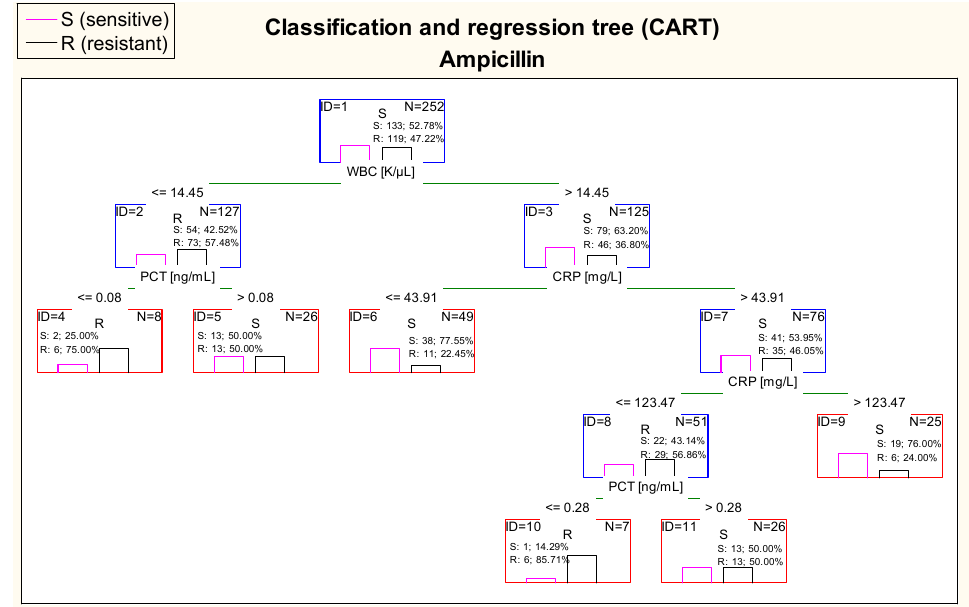
Figure 12. Classification and regression tree (CART) for resistance of Escherichia coli to ampicillin created on the basis of inflammatory markers.